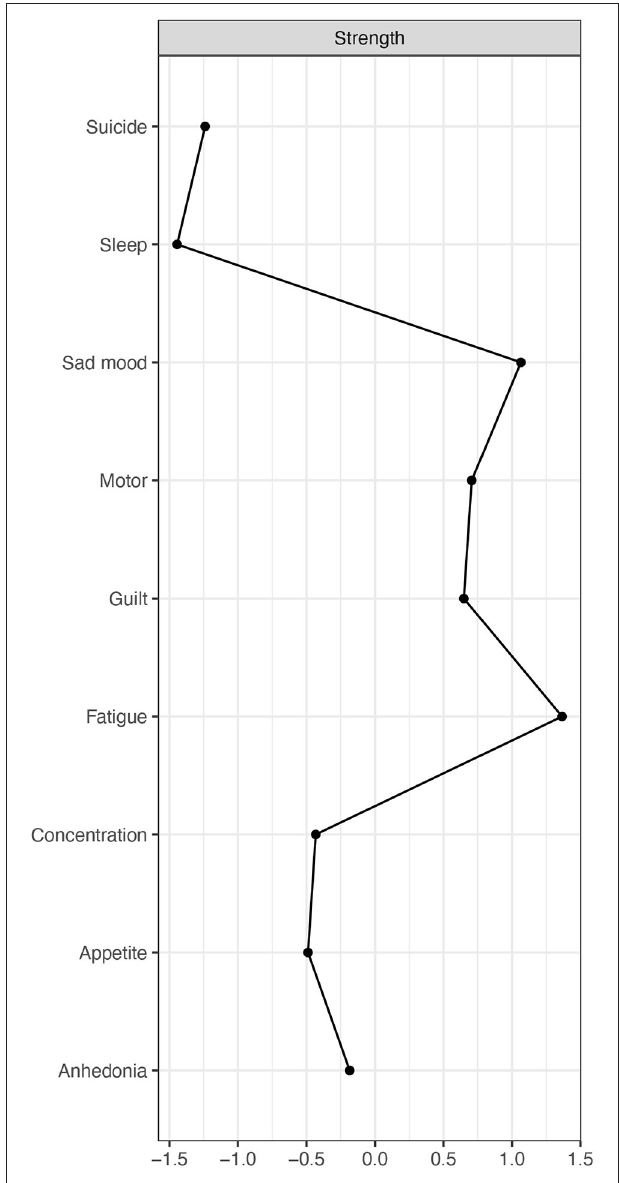
FIGURE 2 | The node strength centrality in the PHQ-9